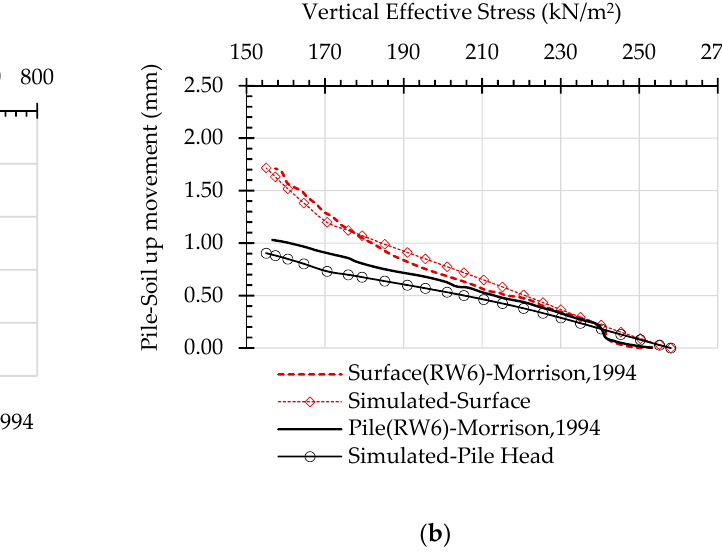
Figure 6. ( a ) Axial pile load–settlement curves from the centrifuge test and simulation; ( b ) vertical effective stress degradation at pile base was positively correlated with pile–soil movement.